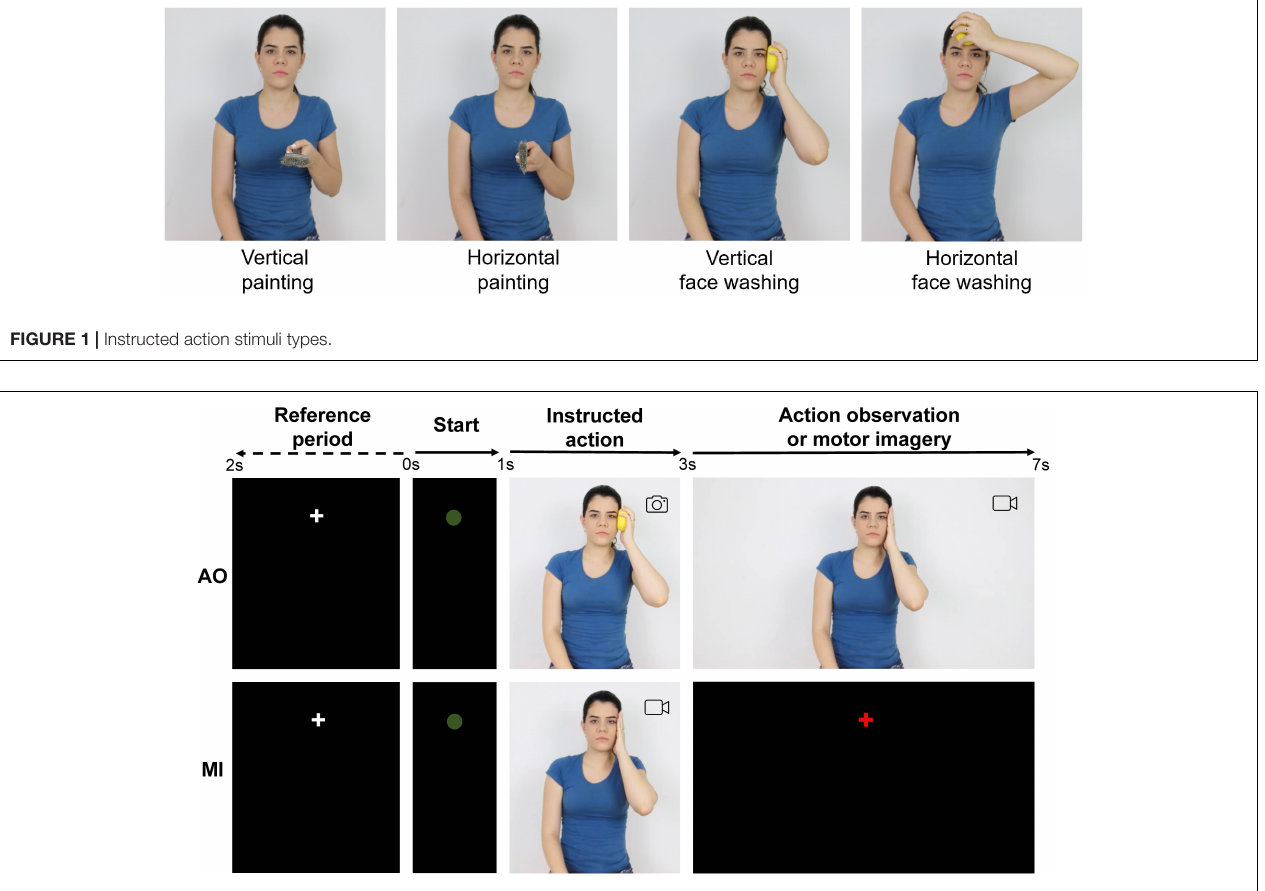
FIGURE 2 | Sequence of events in the two experimental conditions. AO, action observation; MI, motor